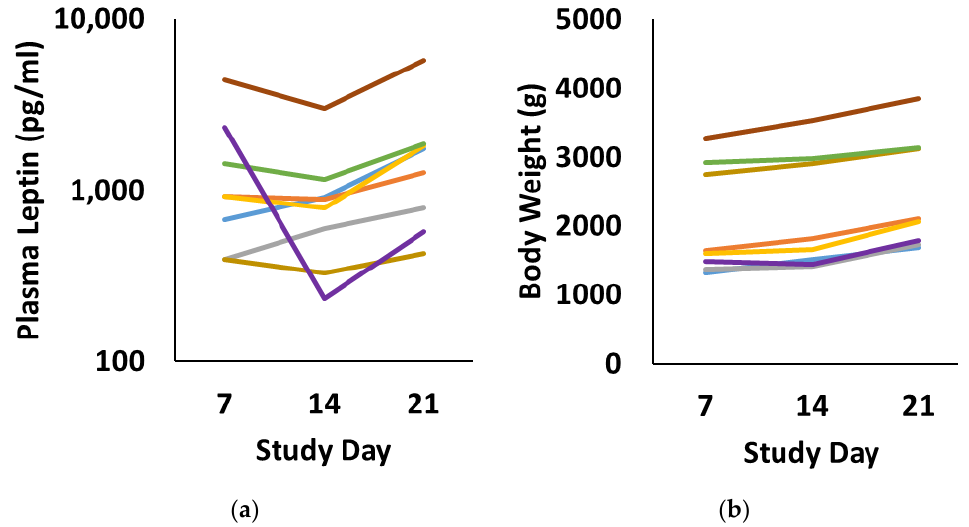
Figure 5. Longitudinal plasma leptin levels ( a ) and body weight ( b ) for each of the 8 infants that completed the clinical study. Study day 7 followed at least 7 days of maternal milk, study day 14 followed 7 intervening days of donor milk, and study day 21 was 7 days following a return to maternal milk. Each infant is represented by a consistent color across both panels.